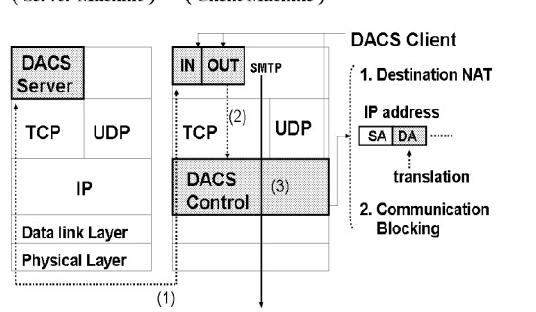
Figure 5. Layer Setting of the DACS Scheme